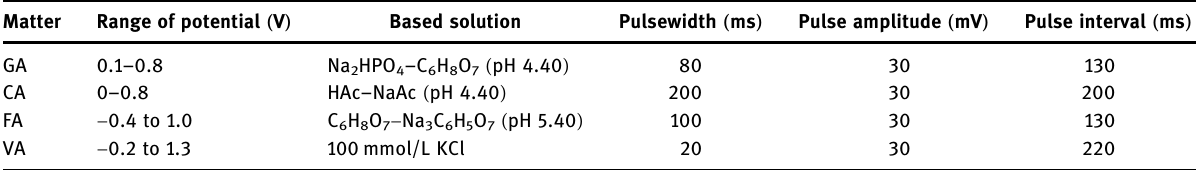
Table 2: The optimum condition of the DPV curve of four polyphenolic compounds Matter Range of potential ( V ) Based solution Pulsewidth ( ms ) Pulse amplitude ( mV ) Pulse interval ( ms ) GA